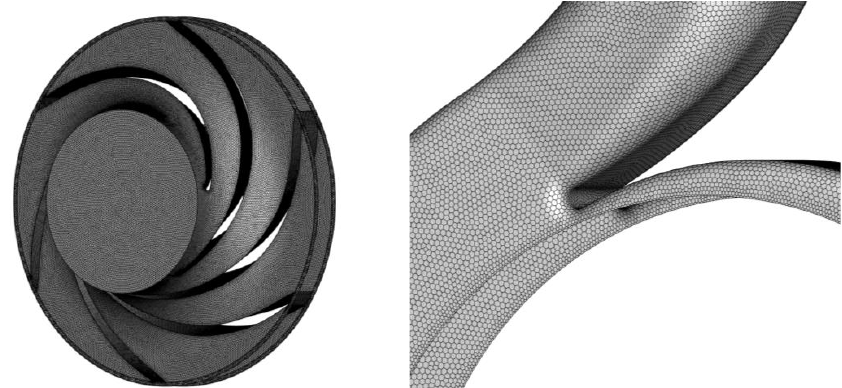
Figure 3. Local mesh division of the impeller water body and volute.